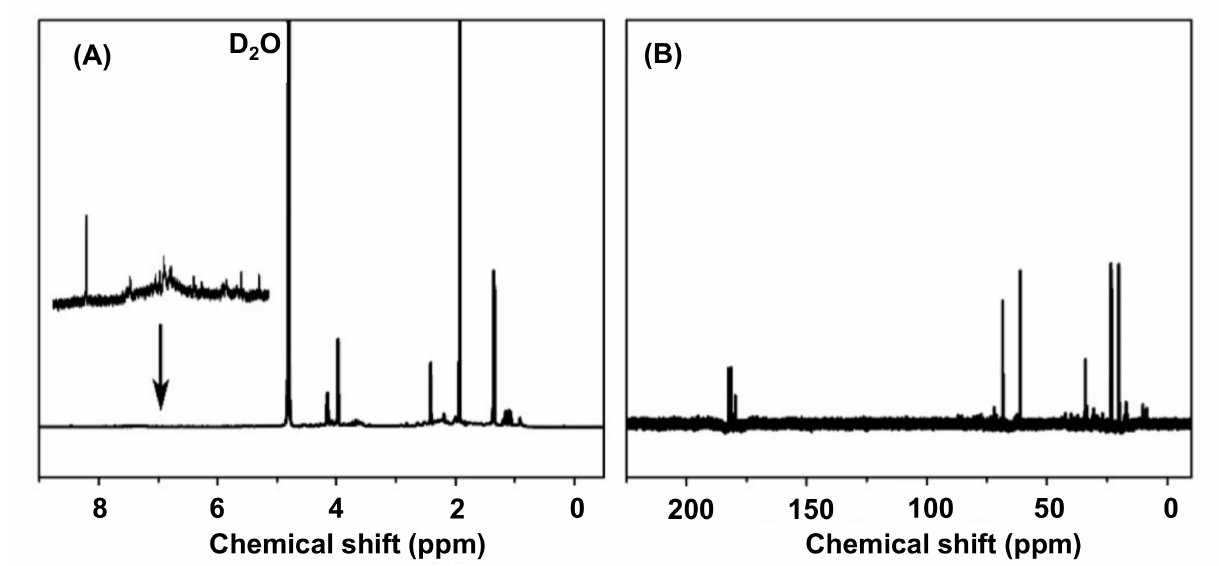
Figure 10. Characterization of CDs by NMR. ( A ) 1 HNMR spectrum. ( B ) 13 CNMR spectrum. Reproduced from [192], with permission from The Royal Society of Chemistry,